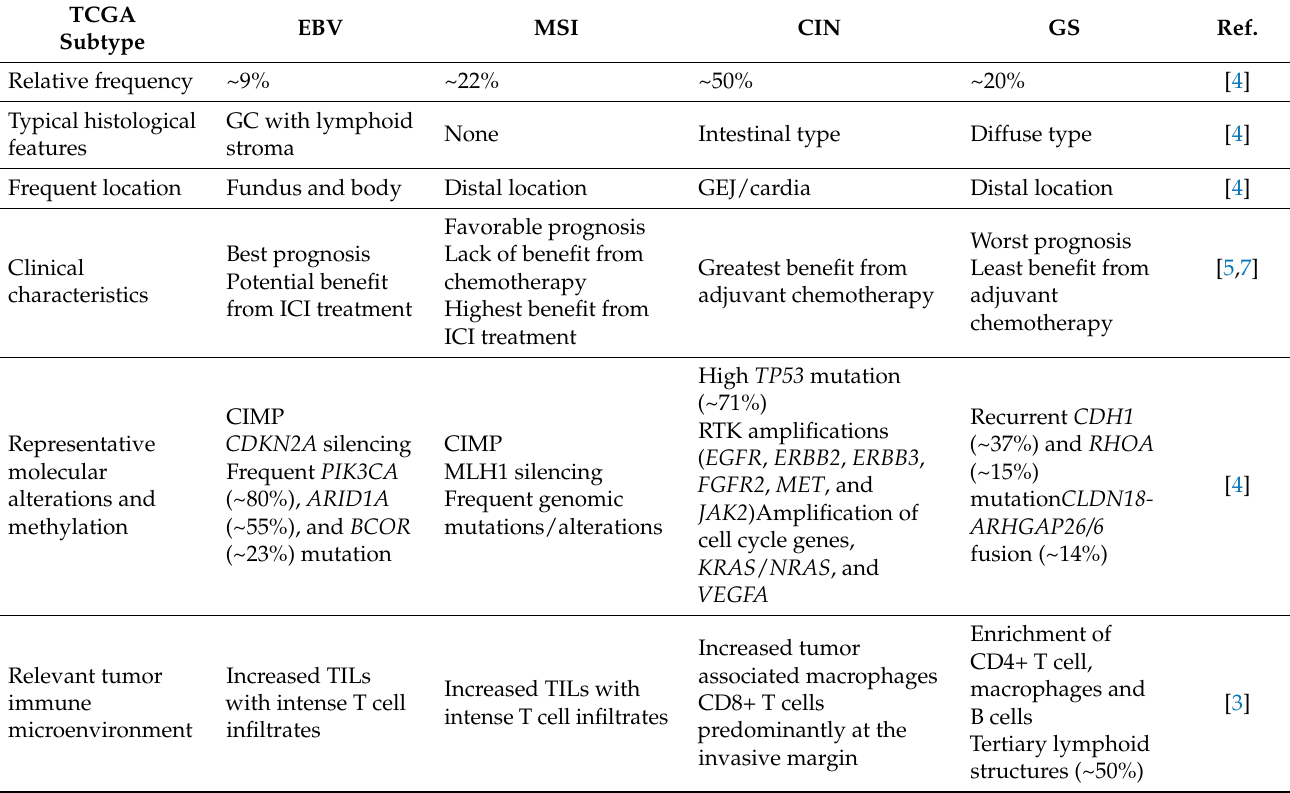
Table 1. Representative features of the four gastric cancer subtypes based on The Cancer Genome Atlas